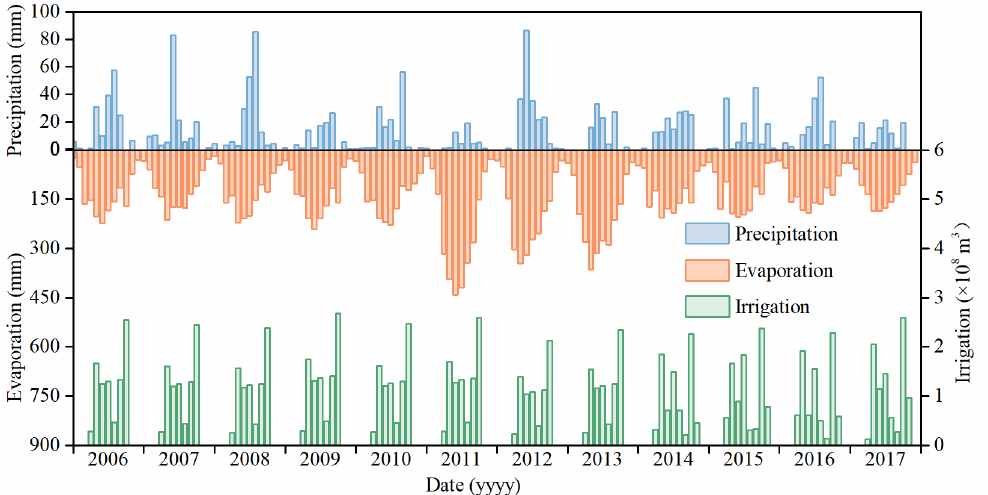
Figure 2. Monthly precipitation, evaporation and irrigation data of Yongji sub-irrigation district during 2006 – 2017.